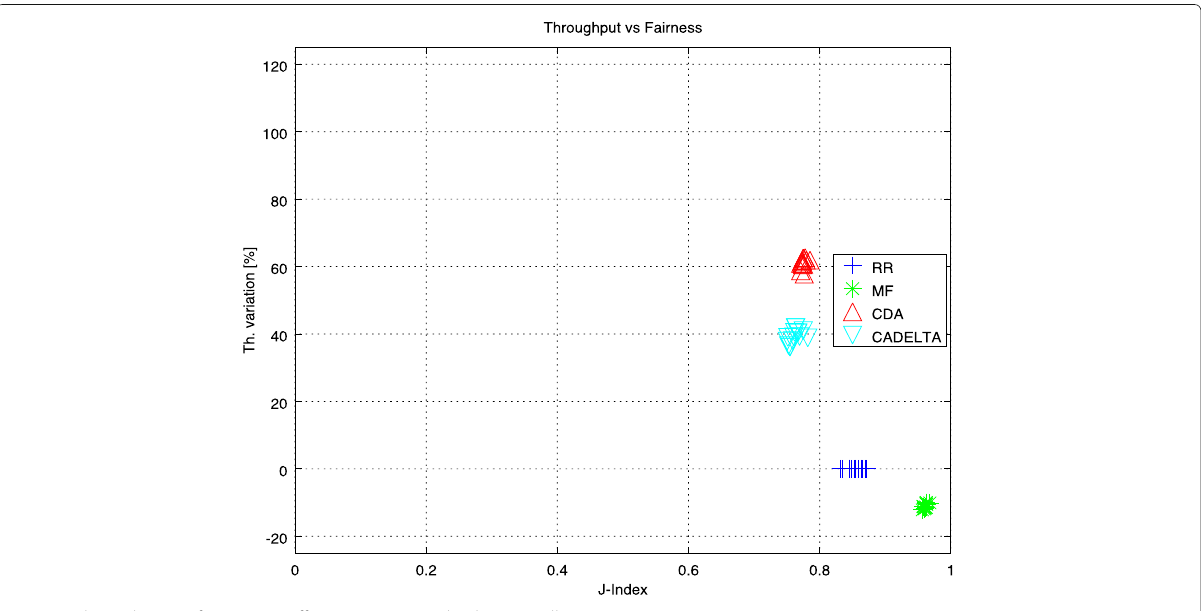
Fig. 11 Throughput vs fairness—traffic monitoring and video surveillance (HQ)